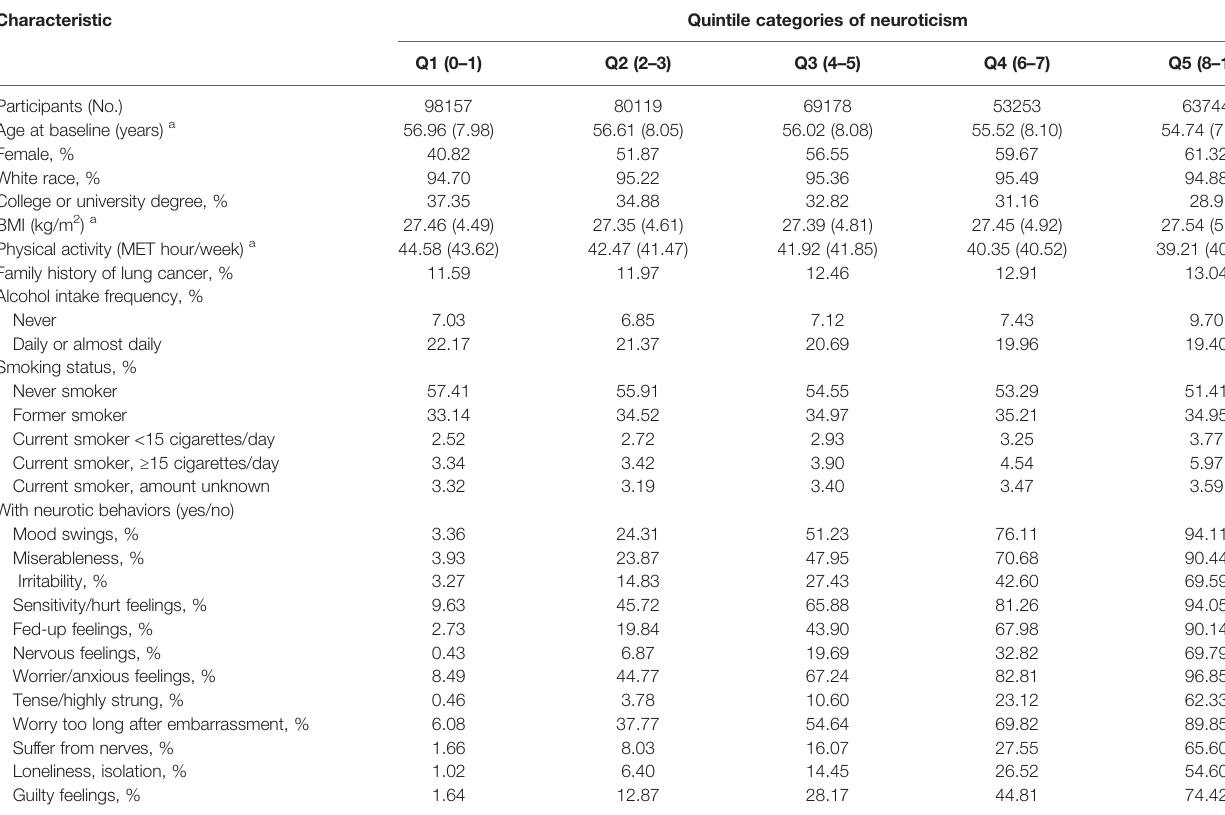
TABLE 1 | Baseline characteristics of UK biobank participants by quintile of neuroticism. Characteristic